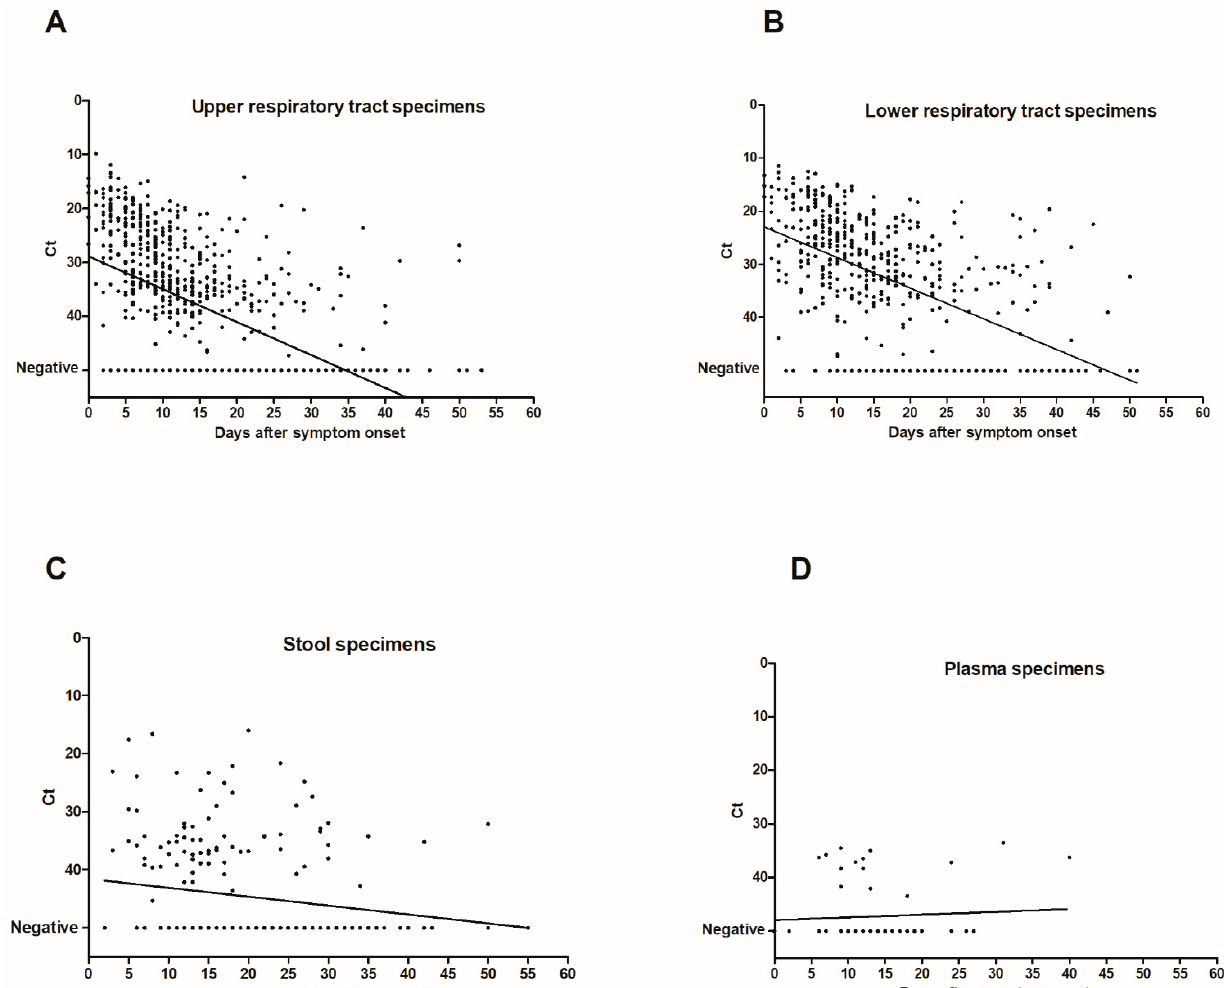
Diagnostics 2021 , 11 , x FOR PEER REVIEW Figure 2. Correlation of Ct values with time after symptom onset. Figure 2. Correlation of Ct values with time after symptom onset.